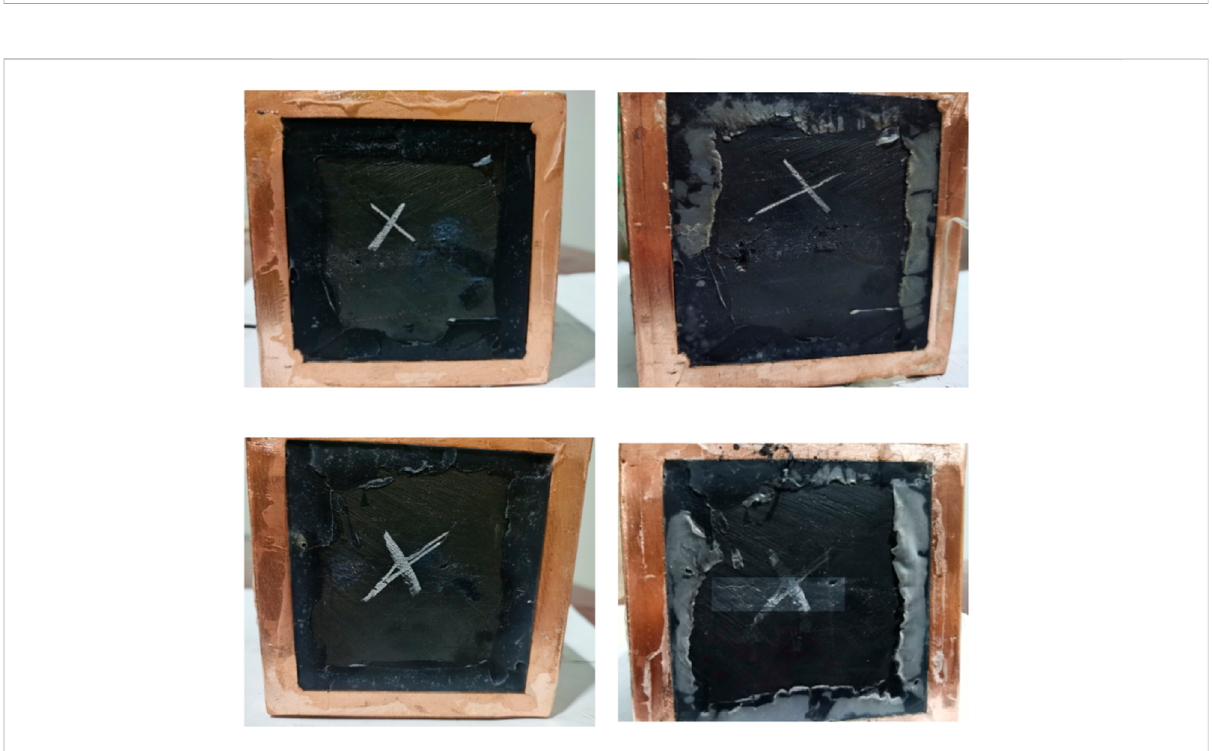
FIGURE 4 Comparison of the X plane before (left) and after (right) the experiment. Note: The fractures are highlighted with transparent frames. Fractures parallel to the bedding plane were